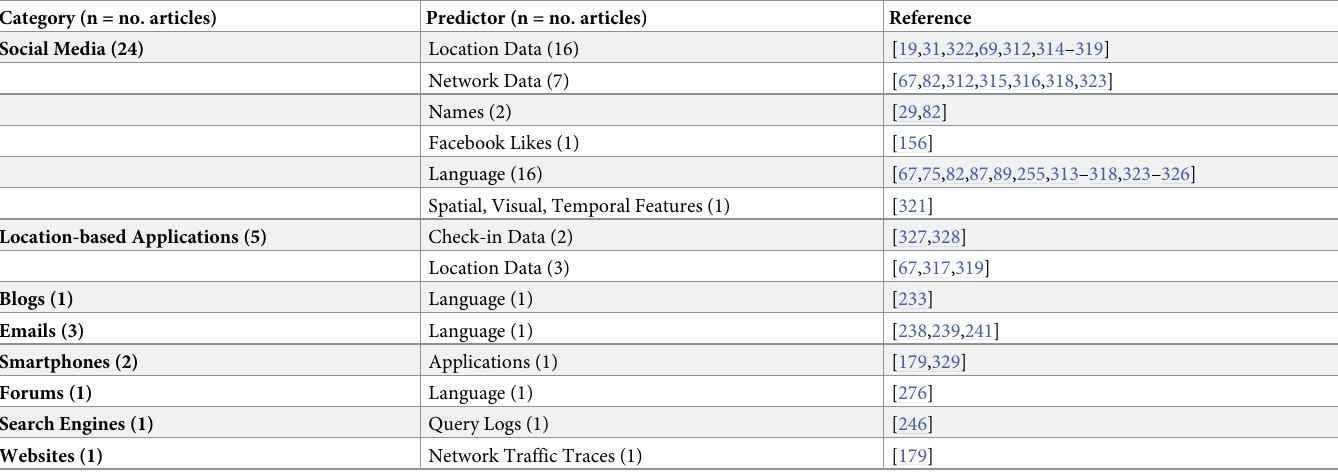
Table 6. Number of articles predicting location, with associated predictors and